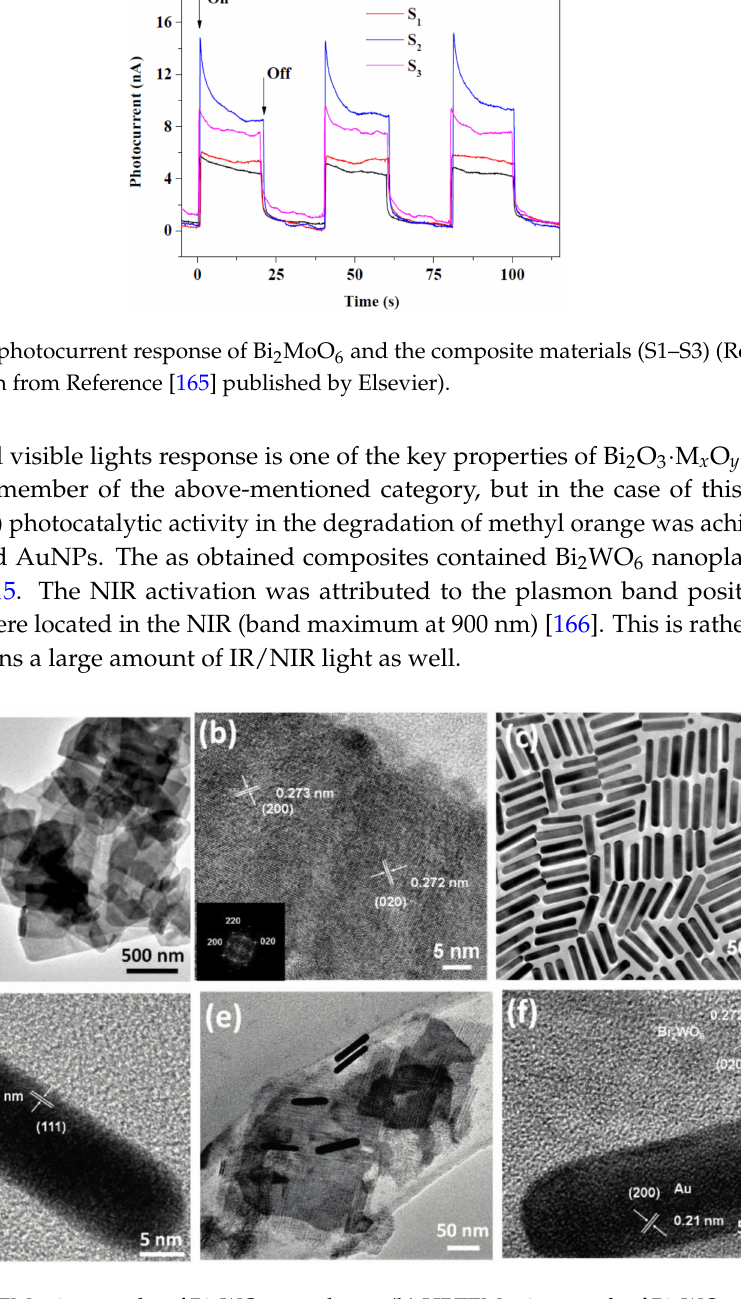
Figure 15. ( a ) TEM micrographs of Bi 2 WO 6 nanosheets; ( b ) HRTEM micrograph of Bi 2 WO 6 nanosheets. Inset: Fourier transformed electron diffraction pattern of Bi 2 WO 6 ; ( c ) TEM and ( d ) HRTEM micrographs of Au nanorods (AuNRs); ( e ) TEM and ( f ) HRTEM micrographs of Au NR/Bi 2 WO 6 heterostructures. (Reproduced with permission from Reference [166] published by John Wiley and